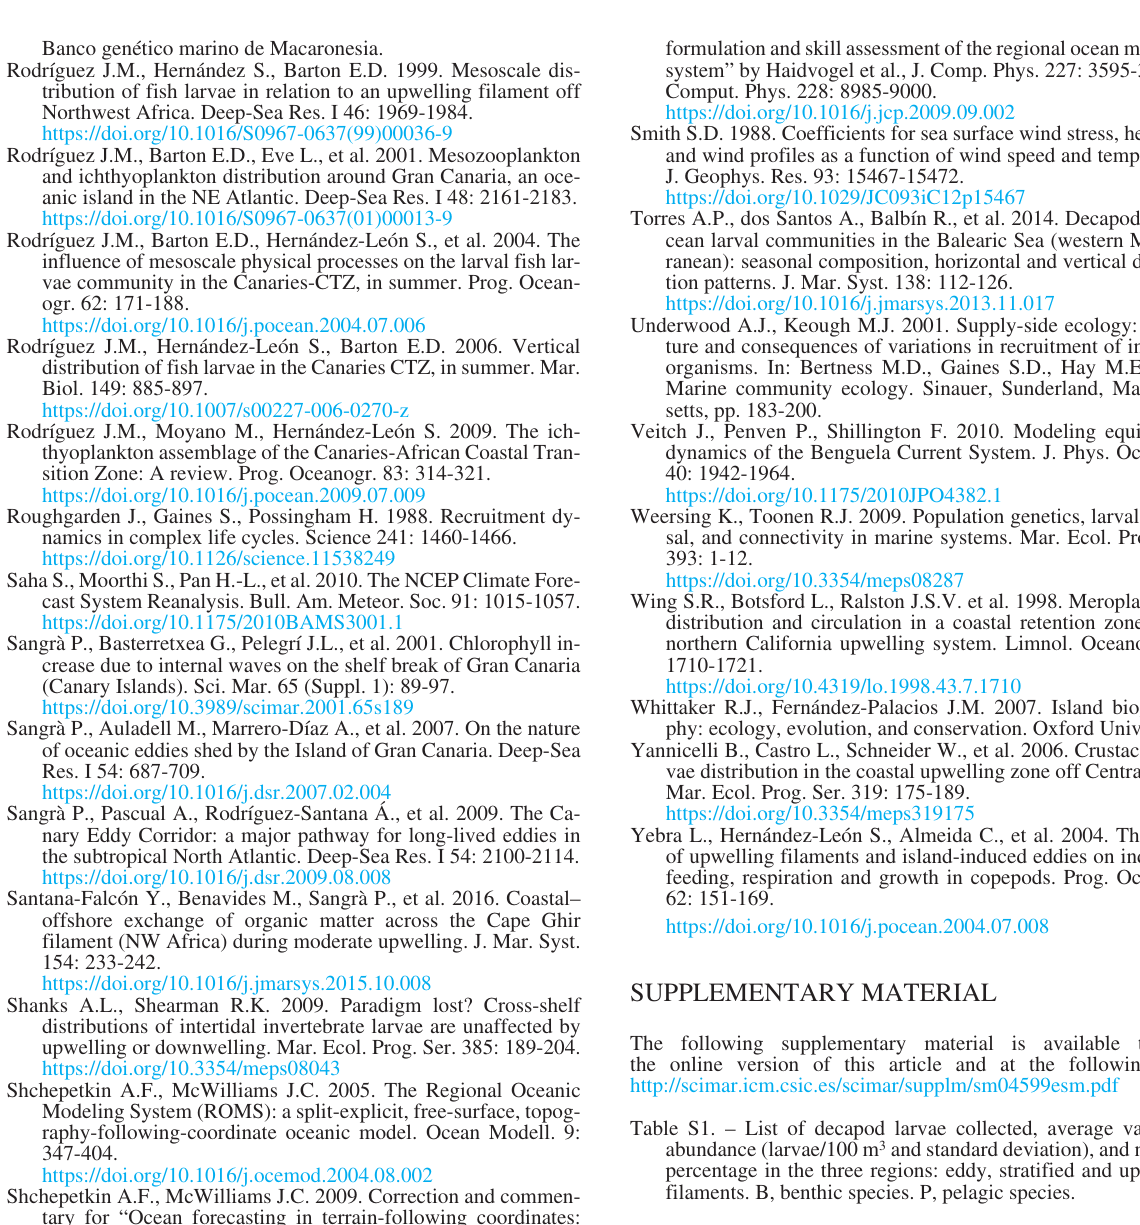
Table S1. – List of decapod larvae collected, average values of abundance (larvae/100 m 3 and standard deviation), and numeric percentage in the three regions: eddy, stratified and upwelling filaments. B, benthic species. P, pelagic